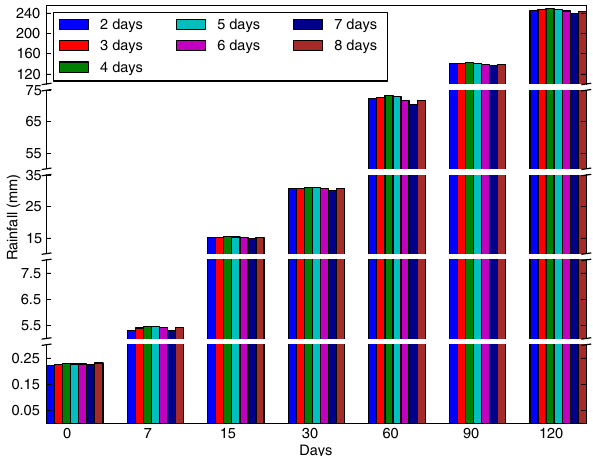
Figure 11. Mean rainfall accumulation before fire in 1997 (based on Fig. 9) in Indonesia with a 0, 7, 15, 30, 60, 90, and 120 days buildup, showing results for all time frames tested to select our correction